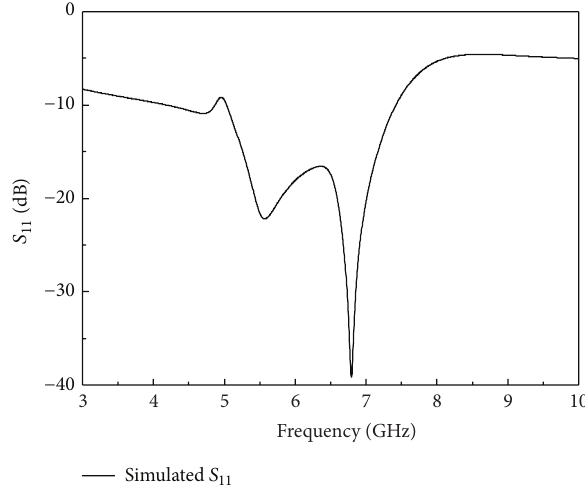
Figure 4: Simulated 𝑆 11 of the proposed Vivaldi circular array.